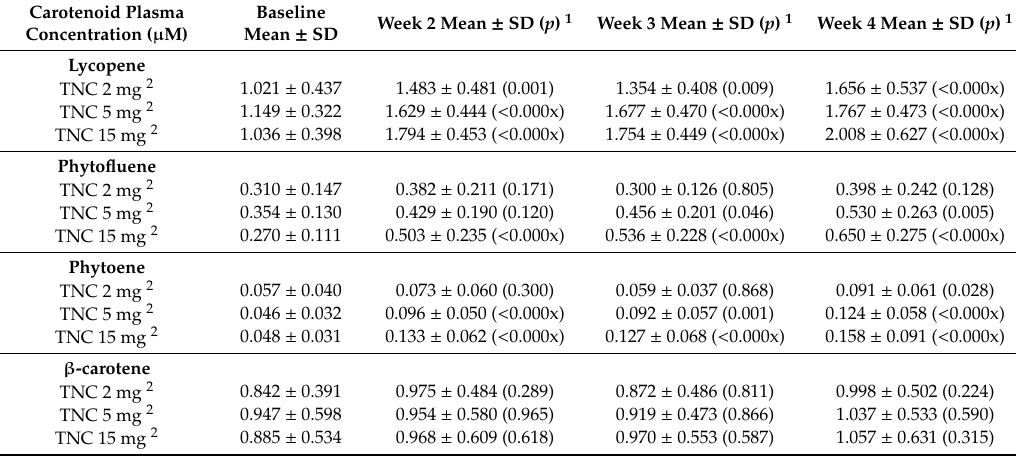
Table 7. Carotenoid plasma concentrations during 4-week treatment with TNC containing 2, 5 and 15 mg